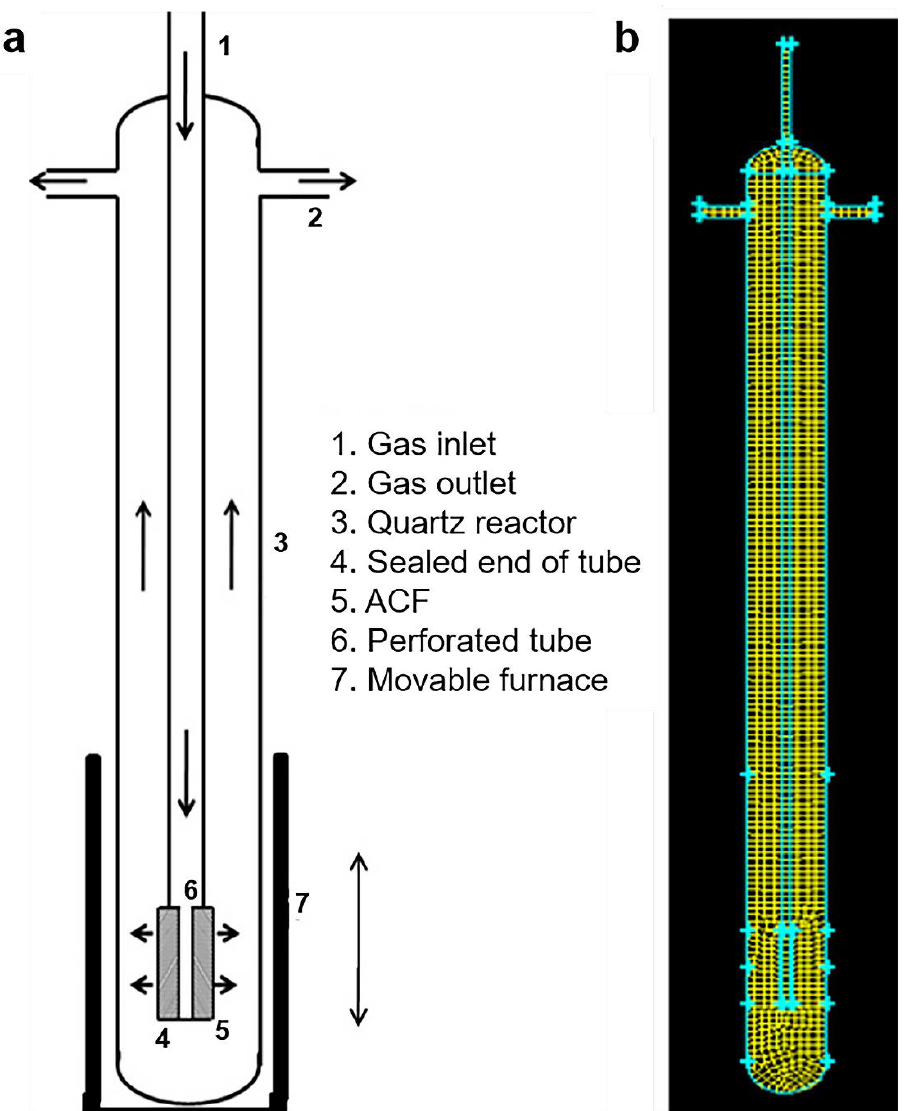
Figure 19. ( a ) Schematic of CVD reactor. ( b ) GAMBIT-mesh for simulation [170]. Copyright © 2021 Elsevier B.V. and the Institution of Chemical Engineers.